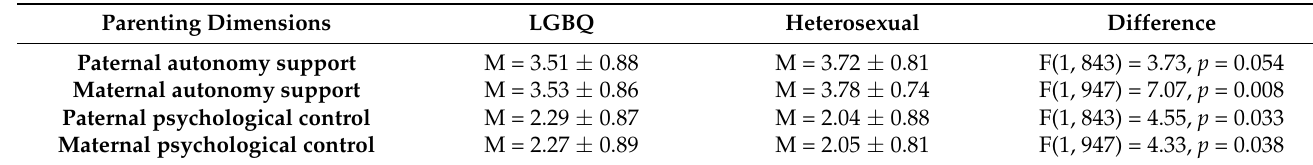
Table 2. Differences in parenting between youth of different sexual orientation.